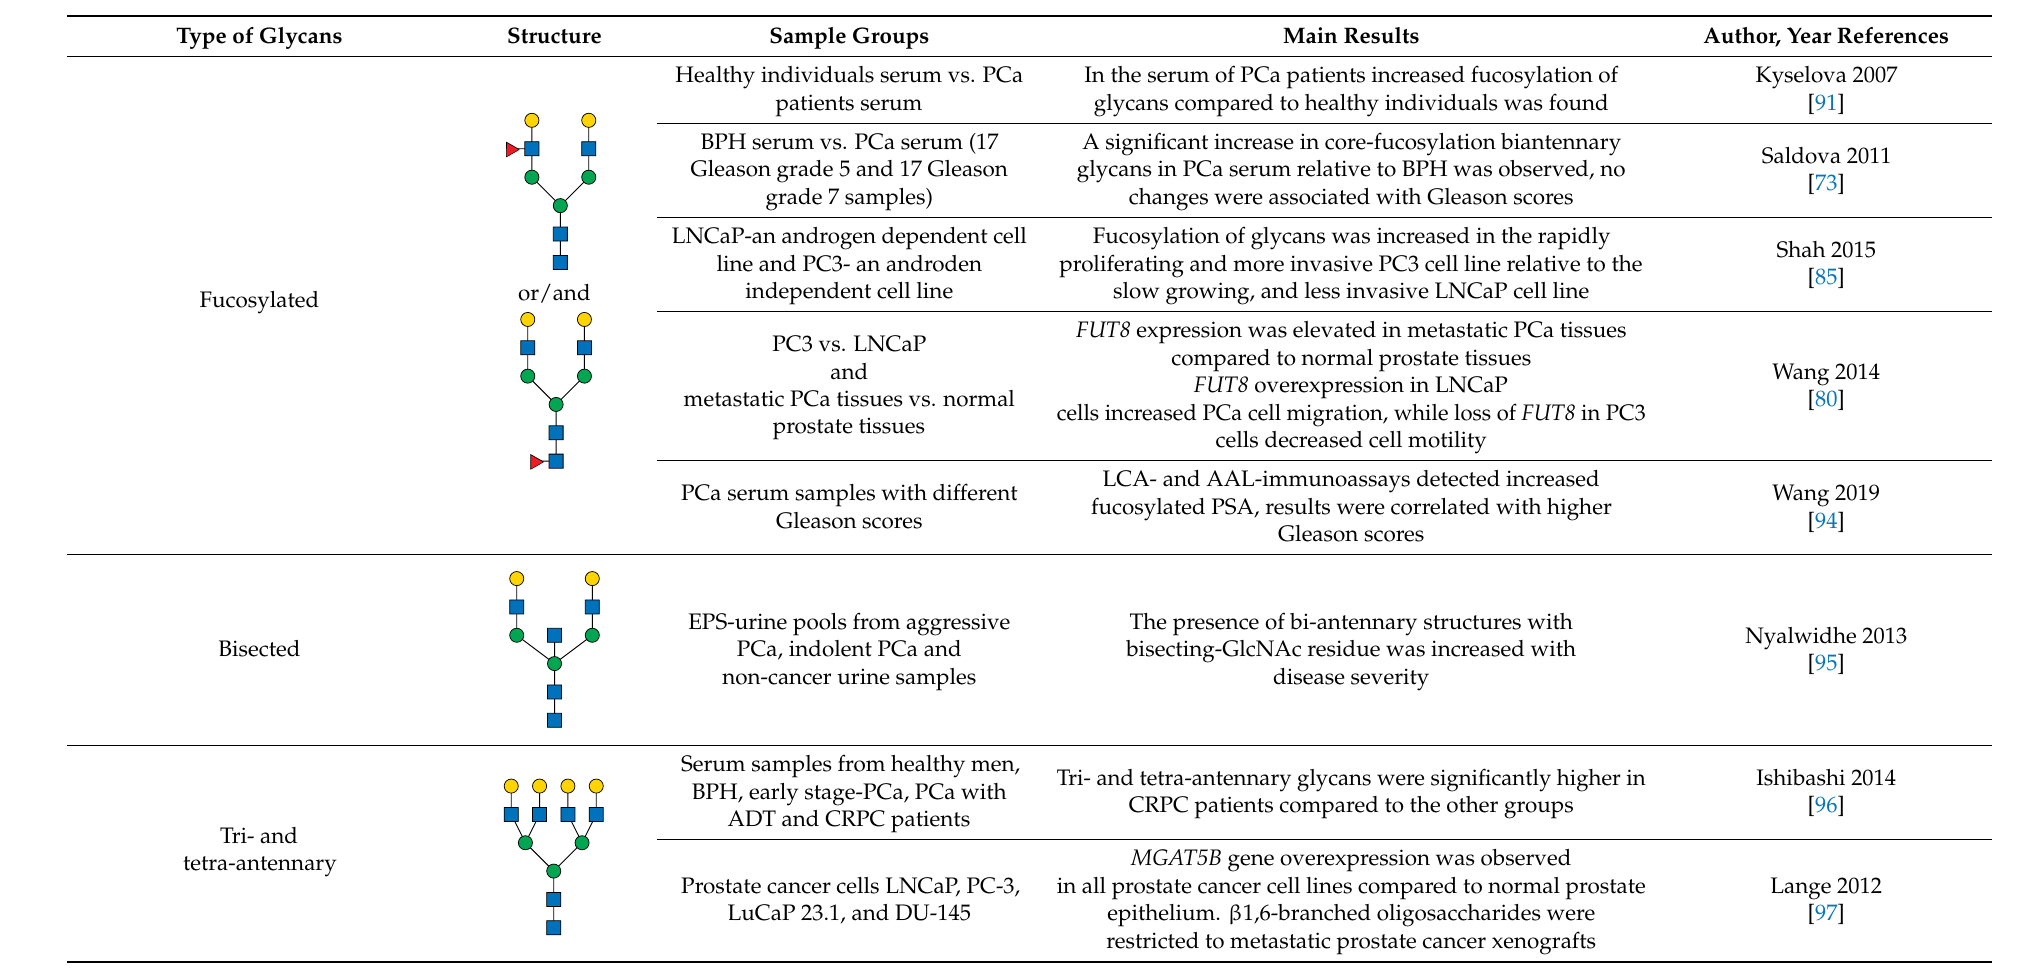
Table 2. Summary of fucosylated, bisected, tri- and tetra-antennary N-glycan alternations in prostate cancer.